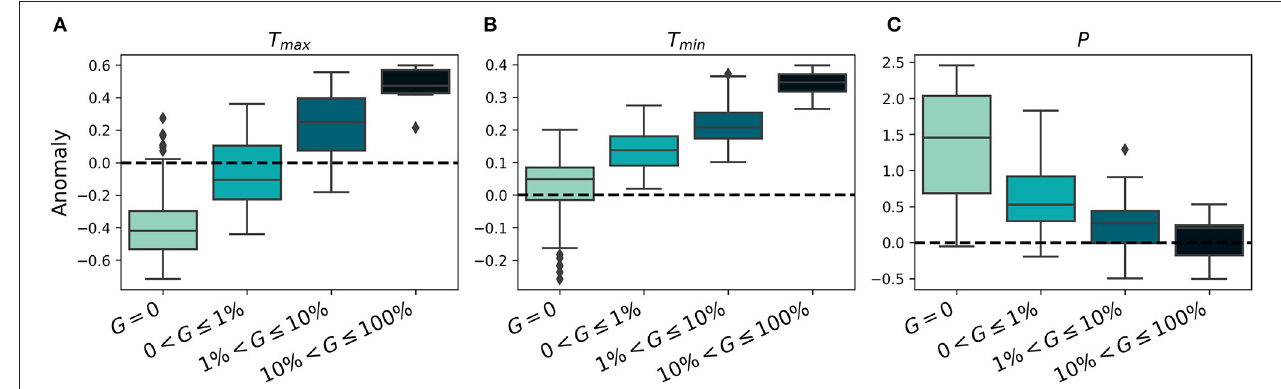
FIGURE 7 | Box plots of daily anomalies of (A) maximum temperature, (B) minimum temperature, and (C) precipitation that precede modeled flow increases in summer, for a given fraction of per-basin glacier cover (G). The dashed black line indicates zero (or average) values. Positive values indicate warmer or wetter than average, while negative values indicate cooler or drier than average. We divide basins into four bins of glacier coverage (no glacier coverage: G = 0; light glacier coverage: 0 < G ≤ 1 % ; moderate glacier coverage: 1 % < G ≤ 10 % ; and high glacier coverage: 10 % < G ≤ 100 % ).